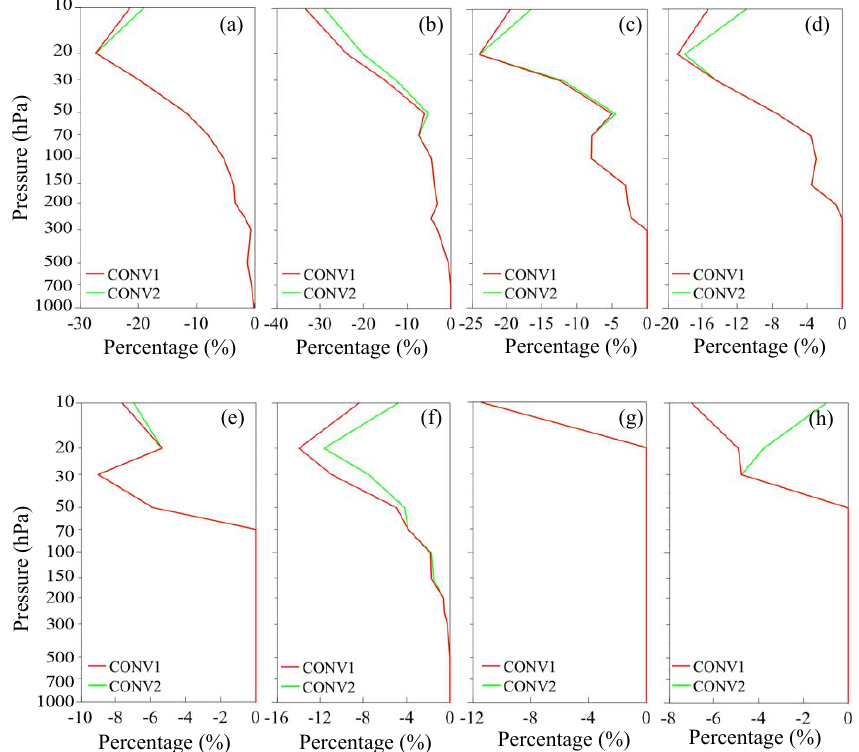
Figure 14. The reduction percentage of CONV1 (red) and CONV2 (green) relative to CTRL1 in the geopotential height RMS of the analysis field difference with NCEP in (a) Northern Hemisphere, (b) Southern Hemisphere, (c) the tropics, and (d) East Asia during 1–27 July 2014. (e) – (h) are similar to (a) – (d) but for U wind.